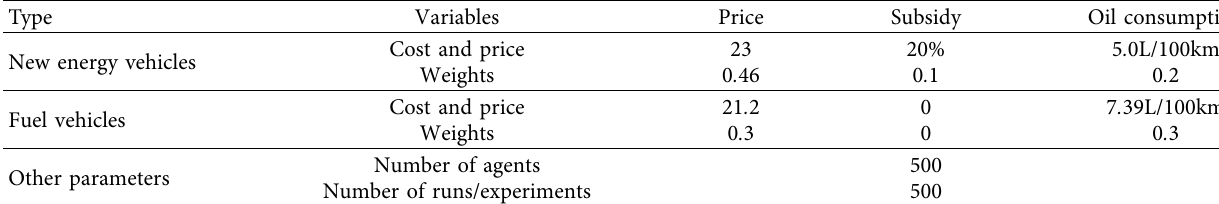
Figure 1: Decision logic for a consumat. Table 1: Basic parameter settings.